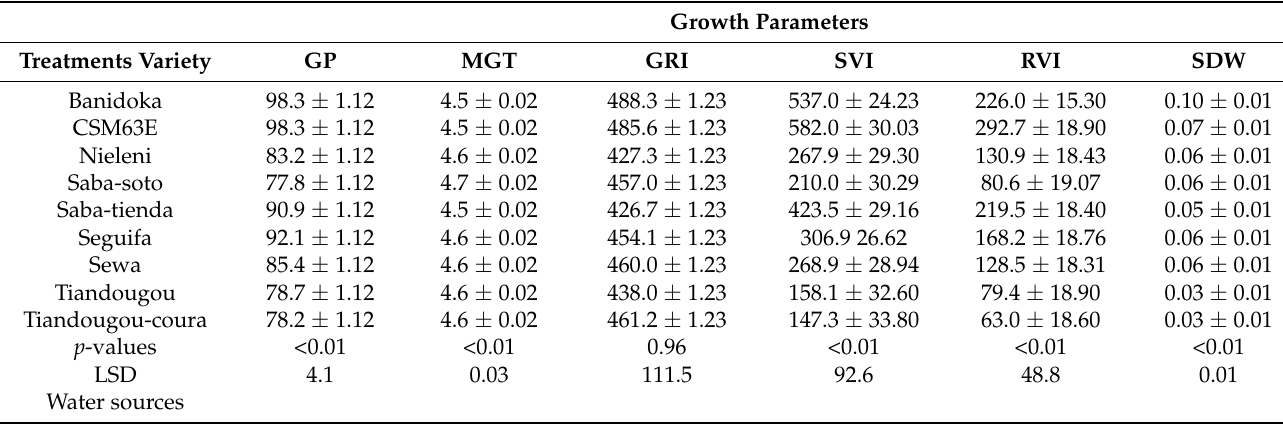
Table 9. Effect of water priming at different durations and with water from different sources on seed germination and growth parameters of nine varieties of sorghum in hot